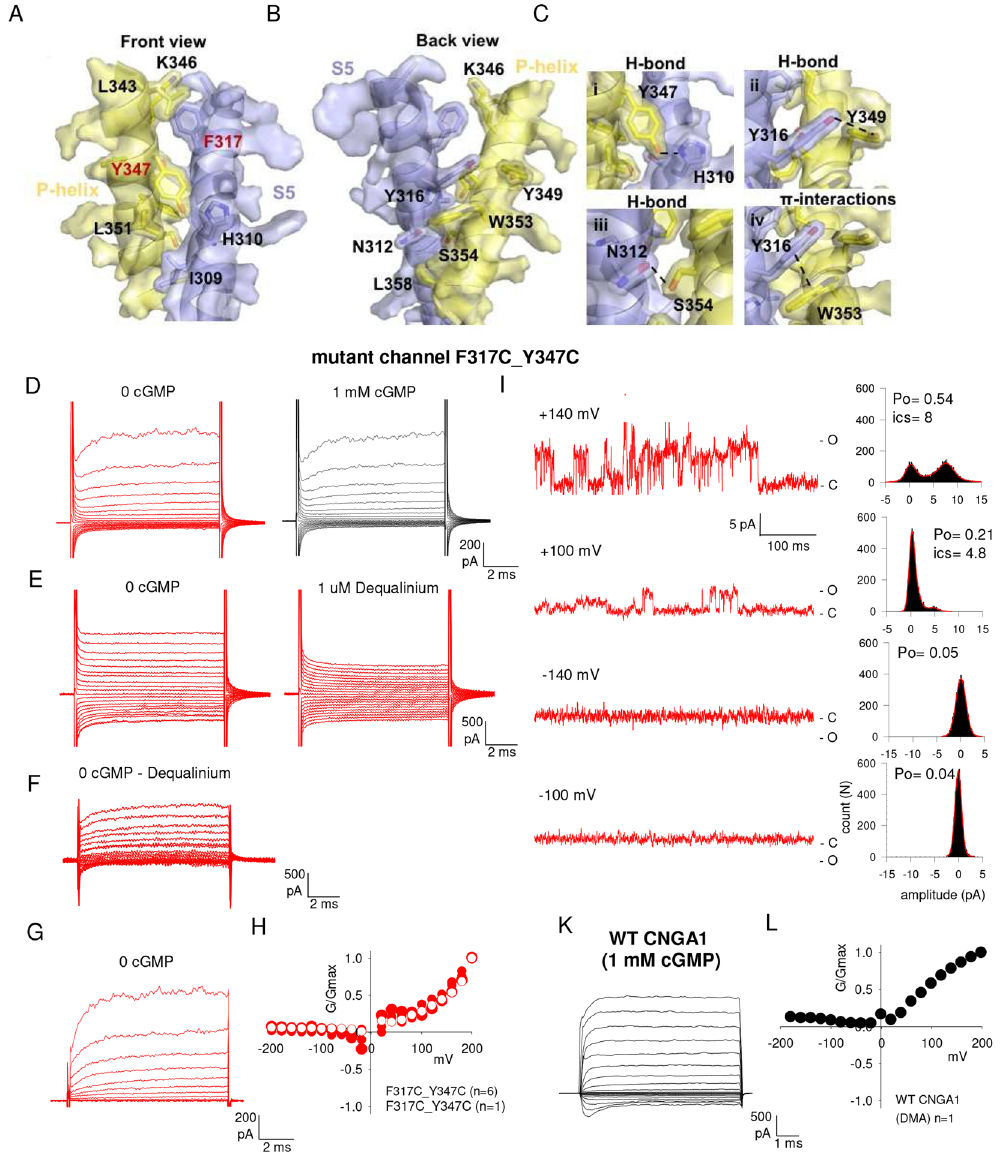
Figure 5. The double mutant channel F317C_Y347C is locked in the open state. ( A , B ) Mapping CNGA1 residues on TAX-4 structure reveals the presence of hydrophobic interactions. ( C ) Enlargement of panels a and b illustrating the network of H-bonds and hydrophobic π -interactions. ( D ) left: current recordings obtained in the absence of cGMP (0 cGMP) for mutant channels F317C_Y347C, elicited by voltage steps from − 200 to + 200 mV ( Δ V = 20 mV); right: after the addition of 1 mM cGMP. ( E ) left: current recordings obtained in the absence of cGMP; right: 1 minute after the addition of 1 µ M dequalinium. ( F , G ) Current recordings obtained in the absence of cGMP following subtraction of those currents recorded in the presence of dequalinium ( F ) or after P/-4 procedure for leak and capacitive artefact subtraction ( G ). ( H ) Dependence of G/Gmax on V with 1 µ M dequalinium and in the absence of cGMP (n = 4, black) and in the presence of 1 mM cGMP (n = 3, red). ( I ) single channel recordings obtained in the absence of cGMP for mutant channels F317C_Y347C, elicited at different voltages. Amplitude histograms are shown at the right of each trace. isc, single-channel current amplitude. ( K ) current recordings obtained from the WT CNGA1 channels in the presence of 1 mM cGMP, elicited by the same voltage steps as in ( D ). ( L ) Dependence of G/Gmax on V obtained from the recordings of WT CNGA1 channels ( K ) in the presence (n = 1) of